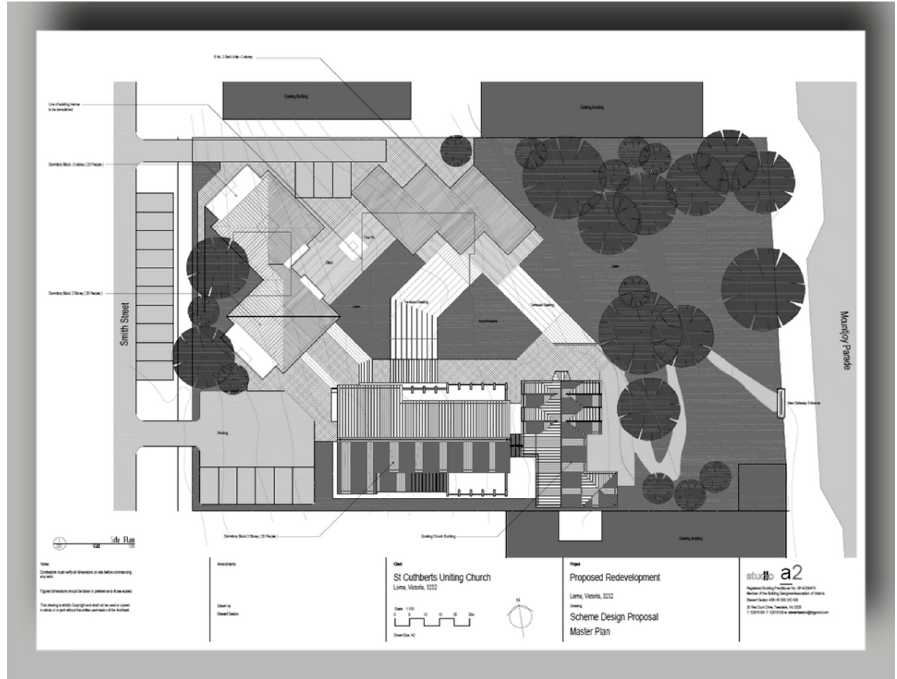
Figure 2. Architectural drawing for the proposed community center. St. Cuthbert’s Church appears at the bottom of the site, right of centre. Source: image reproduced with the consent of the director of studio a2, architect Stewart Seaton.